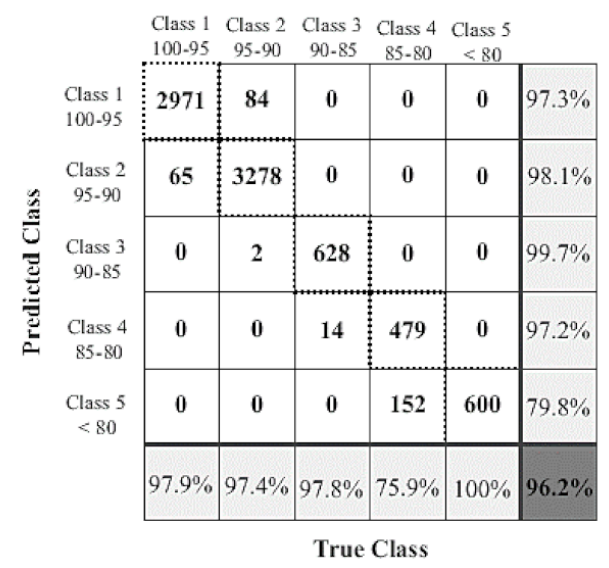
Figure 13. Confusion matrix for performance analysis of ANN-based classifier under dynamic changing load profile validation. The diagonal cells are correctly classified buffers. The last row with gray background is the TPR. The last column with gray background is the precision per class. The bottom right cell with dark background is the total accuracy.